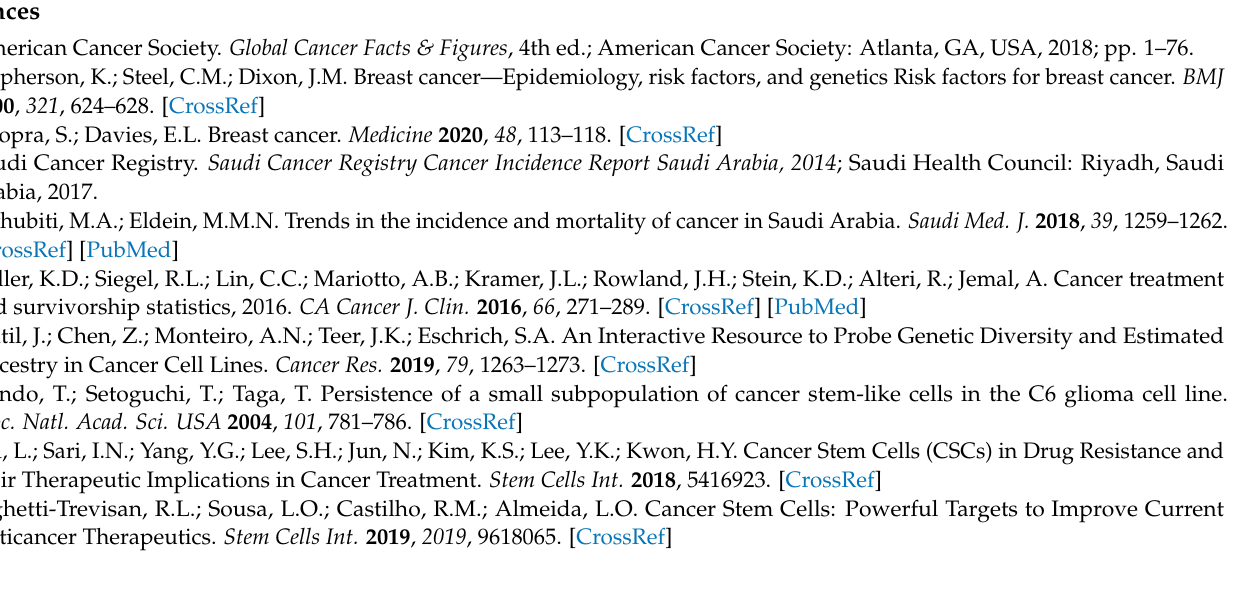
Figure S2: This figure shows all the compounds used in this study for screening drug candidates for breast cancer KAIMRC2 cell line; Figure S3: Western blot analysis of a few of the proteins that showed a similar pattern of expression compared to the KAIMRC1 cell line; Figure S4: Isolation of CD44+ Breast Cancer Stem Cell Population; Video S1: Initiation of adhesion of KAIMRC2 cells on a glass